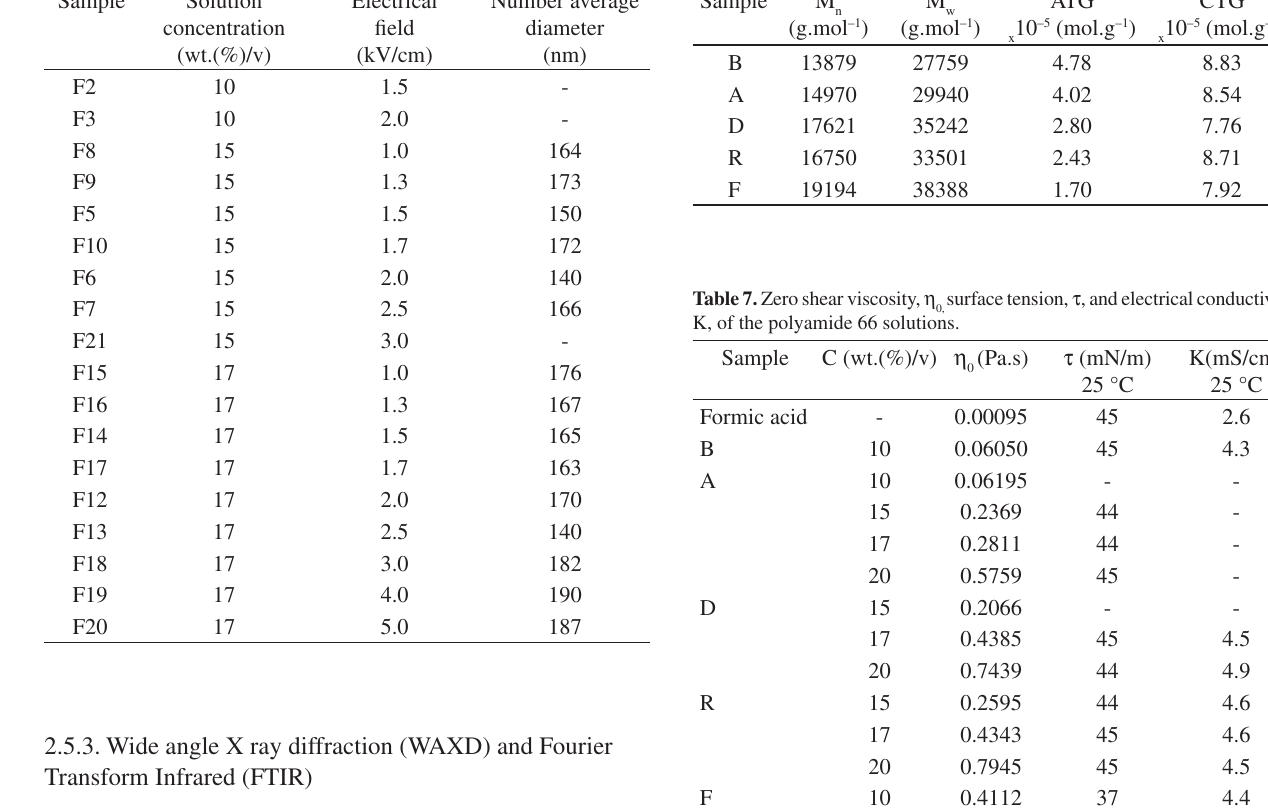
Table 5. Electrospinning conditions of sample F. Sample